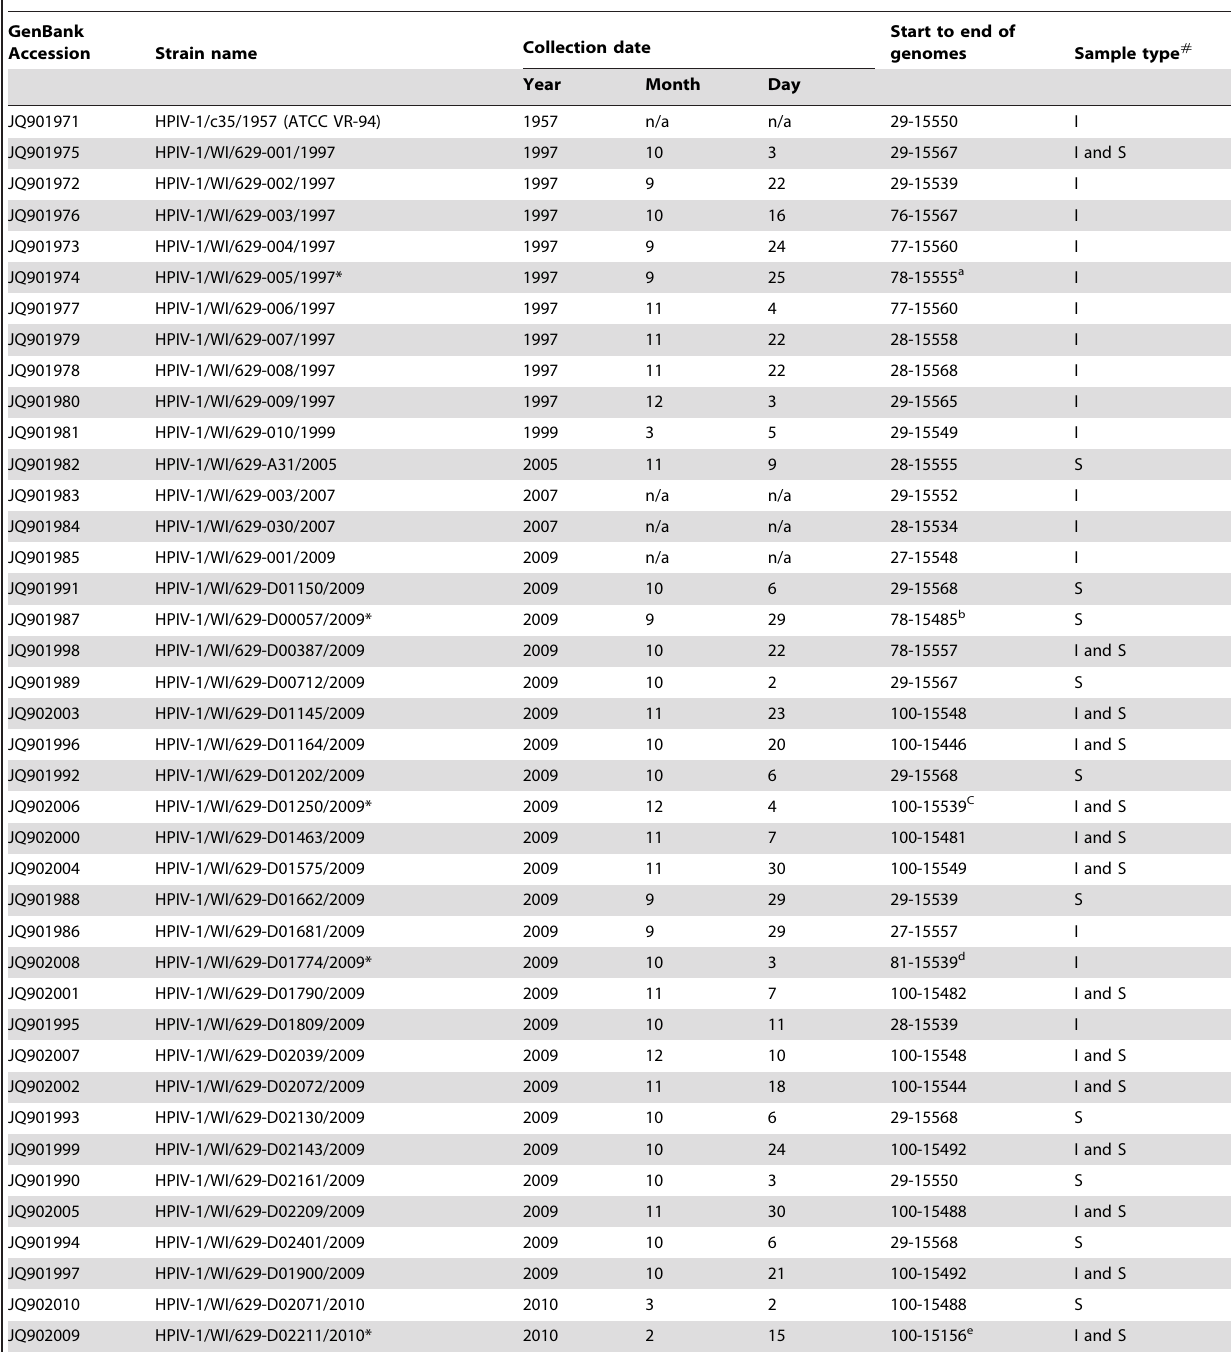
Table 1. Strain Information for all 40 HPIV-1 Genomes